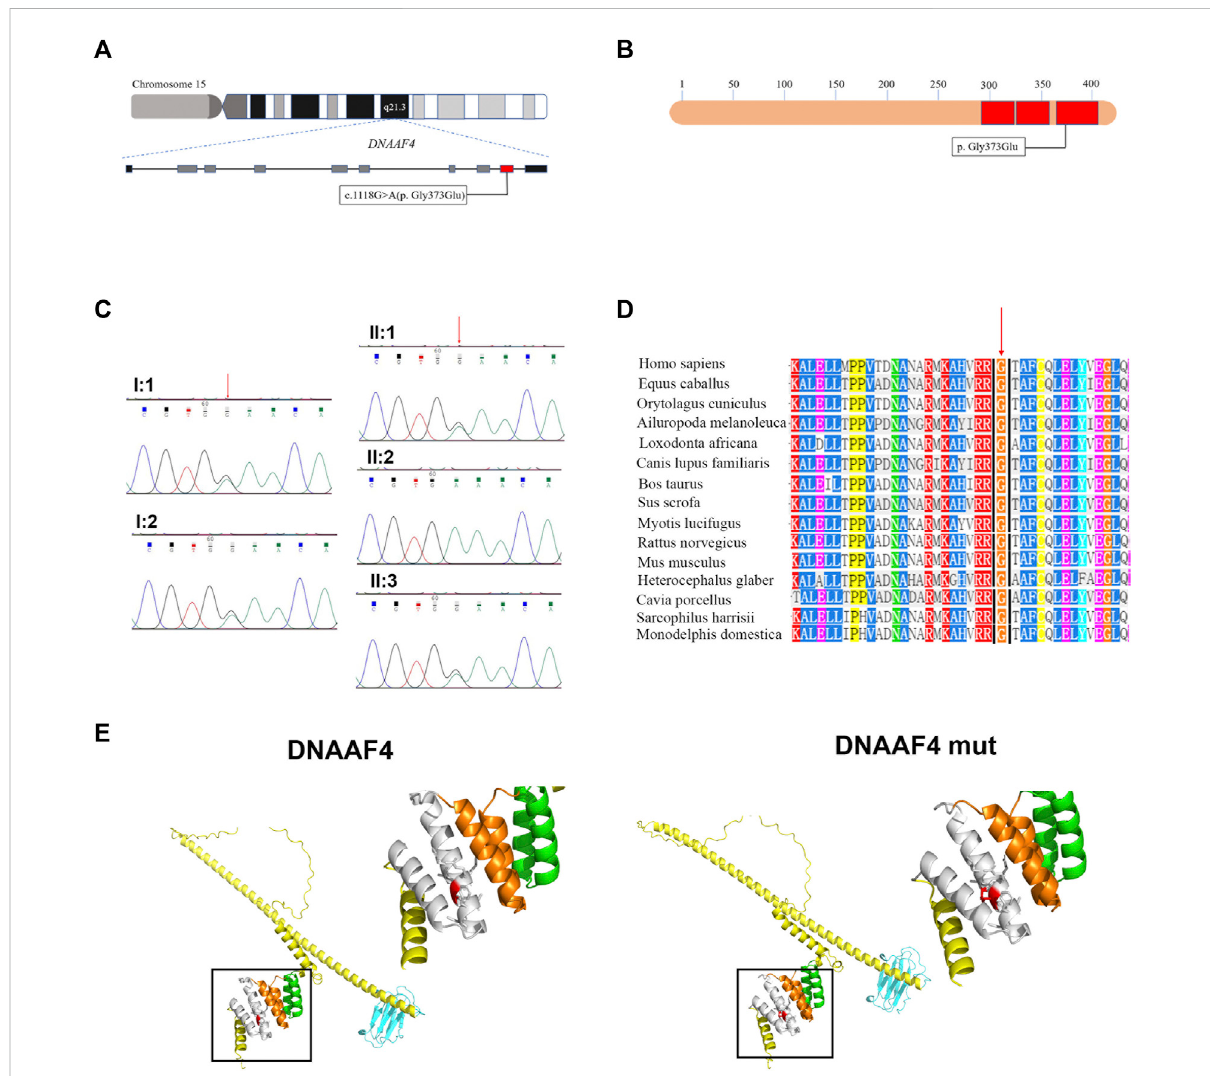
FIGURE 2 Identi fi cation of the DNAAF4 Mutation. (A) Schematic of chromosome 15 and the genomic structure of DNAAF4 . The red rectangle represents exon9. The boxed Mutation was newly found in this study. (B) Schematic showing protein primary structure of DNAAF4; The mutation is located within the TPR domains (red rectangles) at the C terminus of DNAAF4. (C) Sanger sequencing chromatogram ofproband and her family members. A novel homozygous variant DNAAF4 (C) 1118G > A (p. G373E) was identi fi ed in the proband. Her family members were heterozygous at the same position. (D) Orthologous protein sequence alignment of DNAAF4 from different species. The red arrow shows that the novel mutation occurred at highly conserved position in these species. (E) 3D mock structure of DNAAF4 protein. The white, orange, and green indicate the three TPR domains. The variant p. (G373E) is indicated by red color.